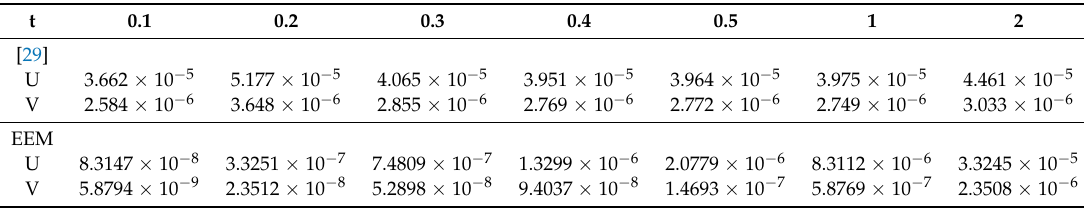
Table 9. Comparisons between the results obtained by the LMM with those adapted from [29] in term of L 2 error norm for Test Problem 7.